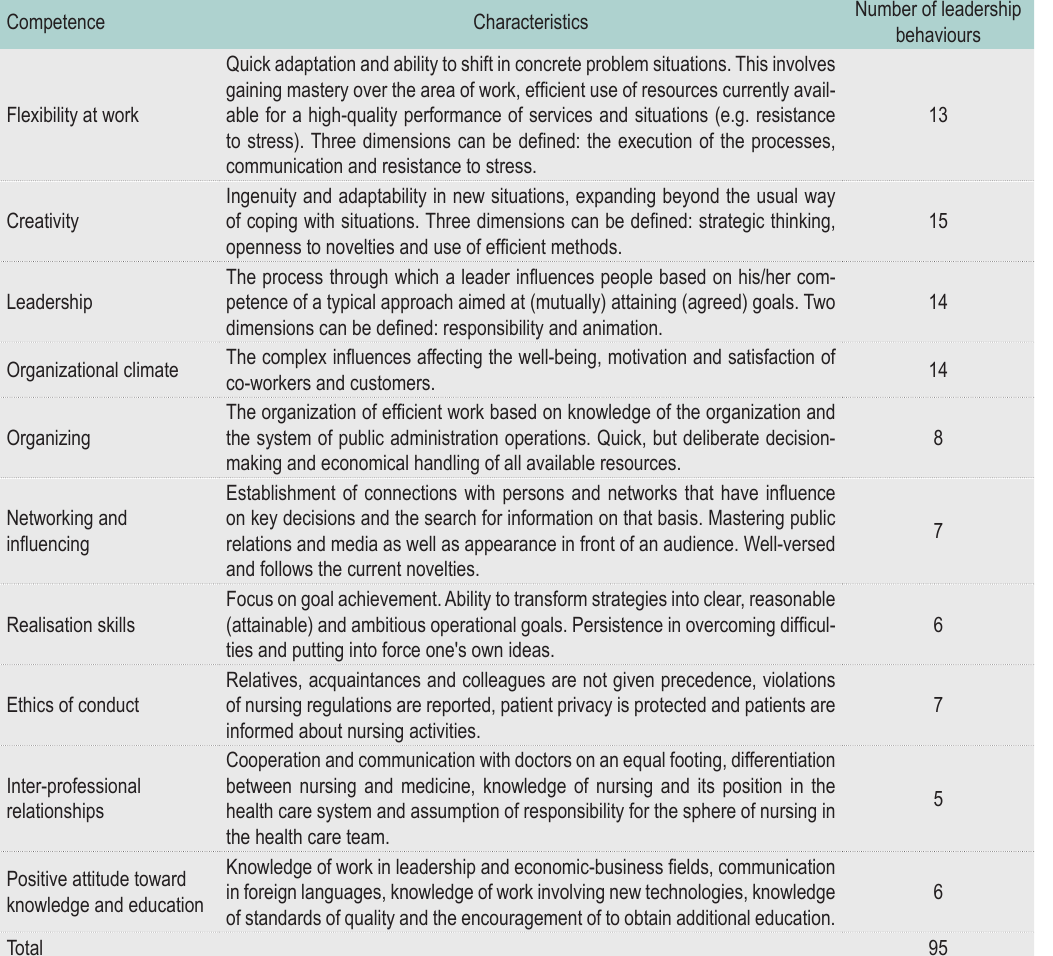
TABLE 1. Description of